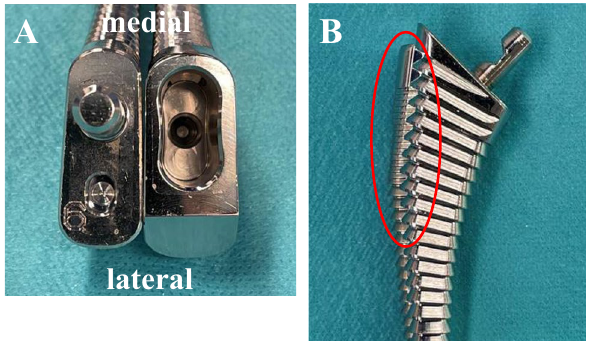
Figure 3. Difference in size of each same number broach. Overlapping the same number 9 broaches with the Corail on top, Hydra broach is more lateral overhanging in proximal part (red oval) than Corail broach in the antero-posterior view ( A ). In the view of each broach from cranial, the antero-posterior width is larger in the hydra broach (left) than the Corail broach (right) ( B